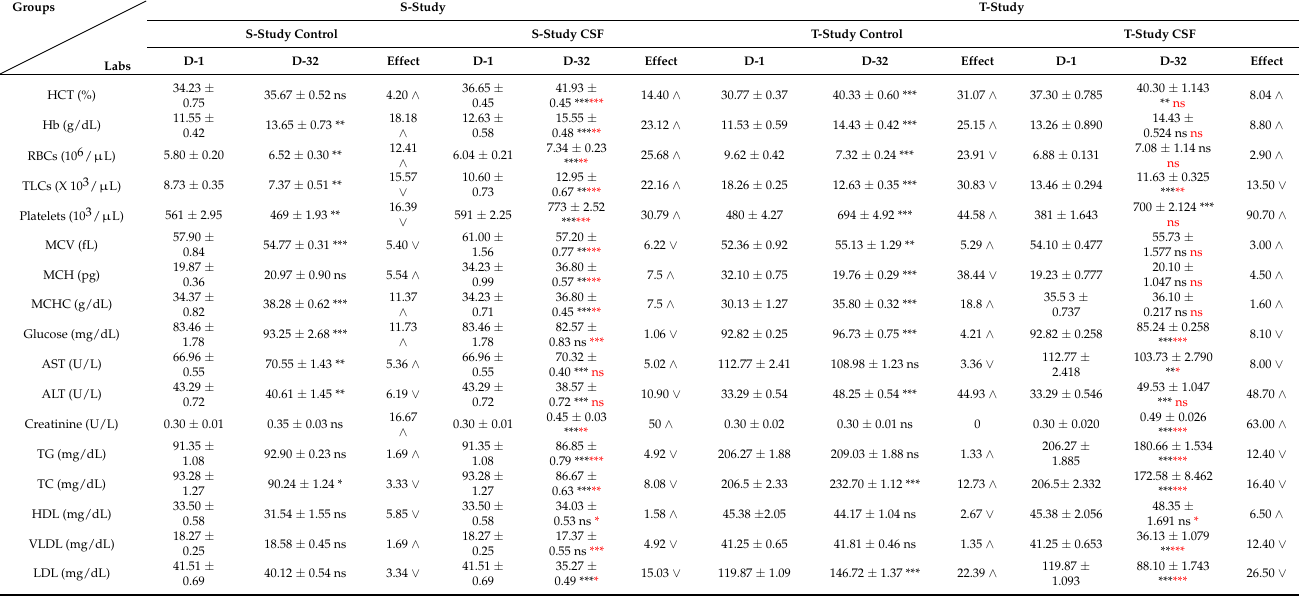
Table 2. Efficacy Results (mean ± SD) for Laboratory biomarkers of S- and